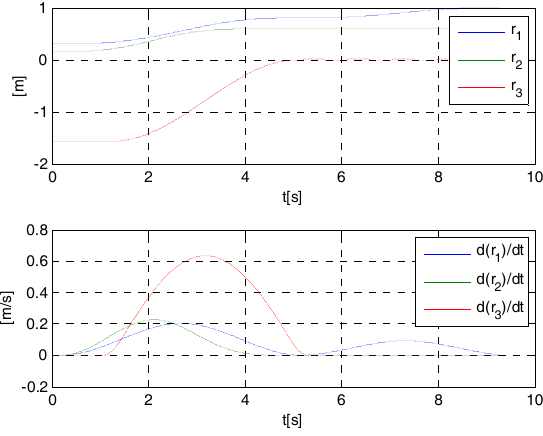
Figure 15. Desired operation (the motion of the payload is in red).